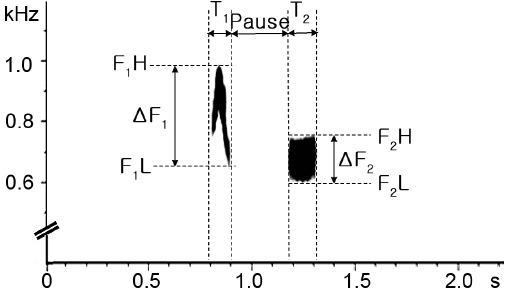
Figure 2. Spectrogram of a male cuckoo call with 9 measurable variables. T 1 and T 2 denote the duration of syllables 1 and 2, respectively; a pause represents the temporal gap between syllables 1 and 2; F 1 H and F 2 H indicate the highest frequency of syllables 1 and 2, respectively; F 1 L and F 2 L denote the lowest frequency of syllable 2. D F 1 and D F 2 represent the difference between the highest and the lowest frequencies of syllables 1 and 2, respectively. PF1 and PF2 are the peak frequencies of syllables 1 and 2, respectively and D PF denotes the difference between the peak frequencies of syllables 1 and 2.